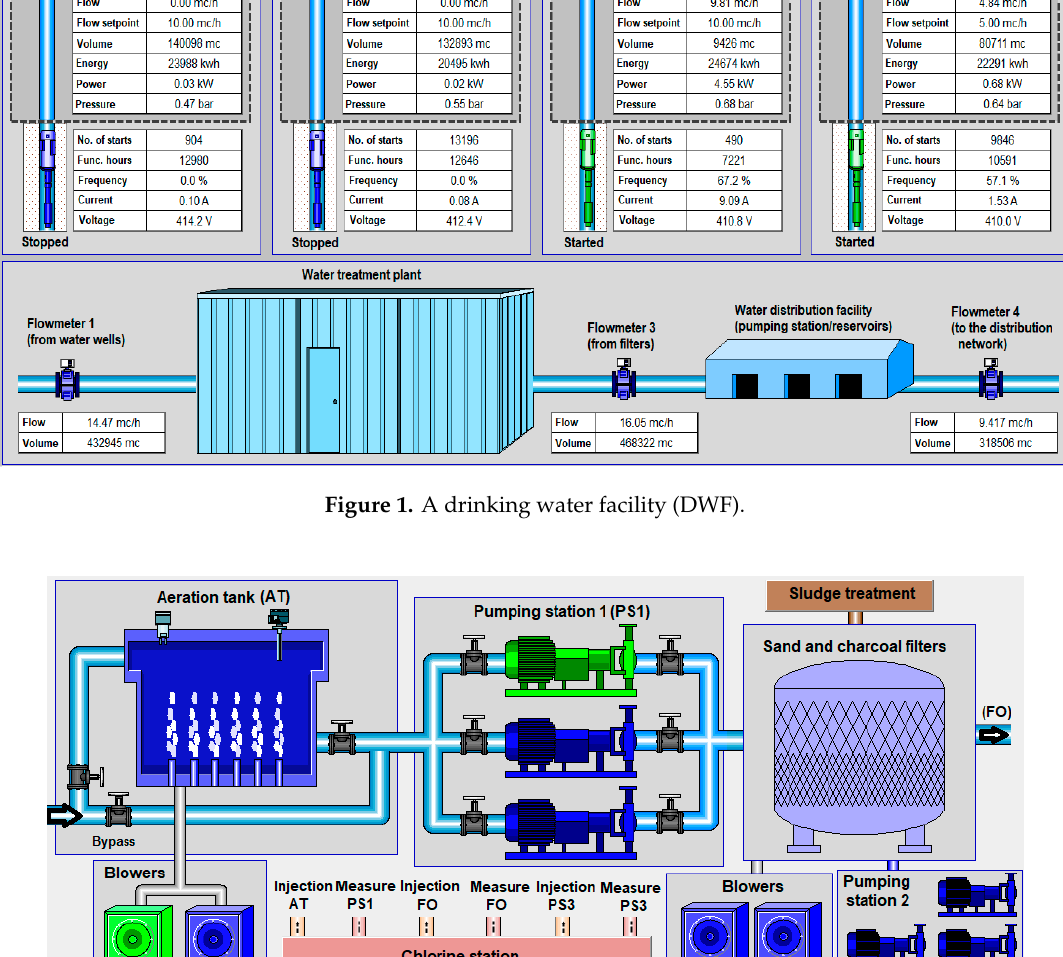
Figure 2. A water treatment plant (WTP).